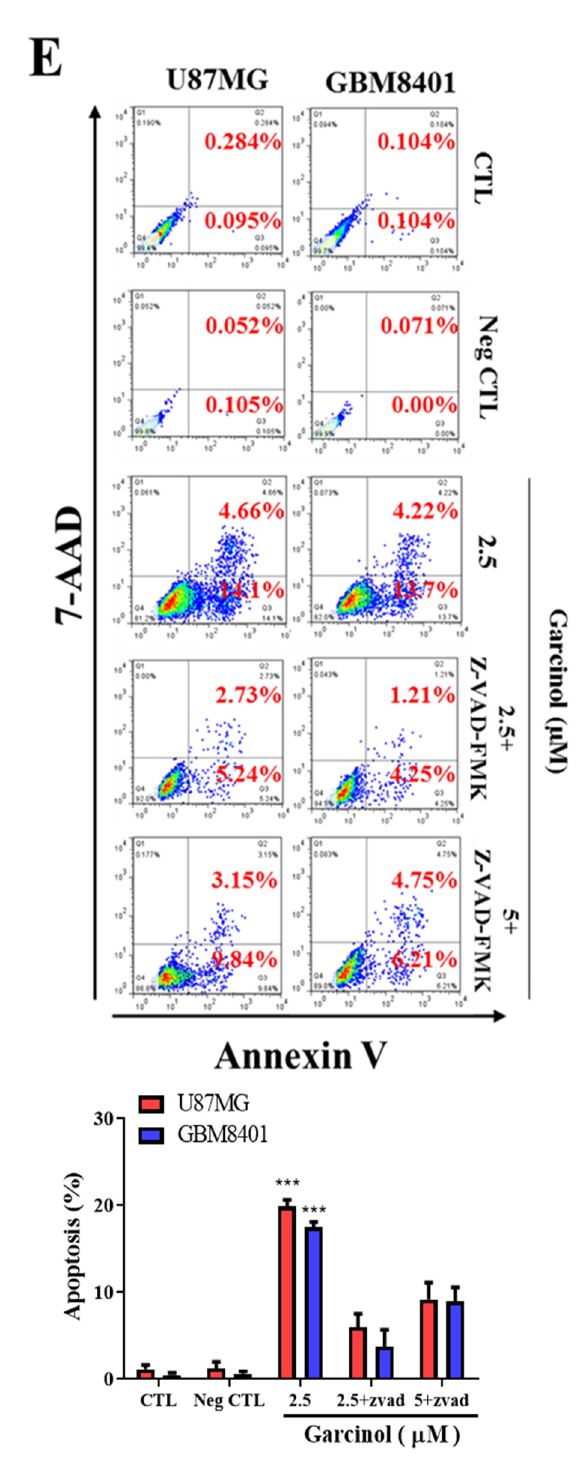
Figure 2. ( E ) Flow-cytometry data (upper) and graphical representation (lower) showing the effect of garcinol, alone or in presence of Z-VAD-FMK, on U87MG or GBM8401 cells co-stained with PE-conjugated annexin V and 7-AAD, compared with untreated control or Z-VAD-FMK-treated negative control groups. Annexin V-stained Q3 cells are early apoptotic cells, whereas Q2 cells are late apoptotic (necrotic) cells. Apoptosis (%), sum of Q3 + Q2; CTL, vehicle-treated; Neg CTL, pan-caspase inhibitor benzyloxycarbonyl-Val-Ala-Asp-fluoromethyl ketone (Z-VAD-FMK).